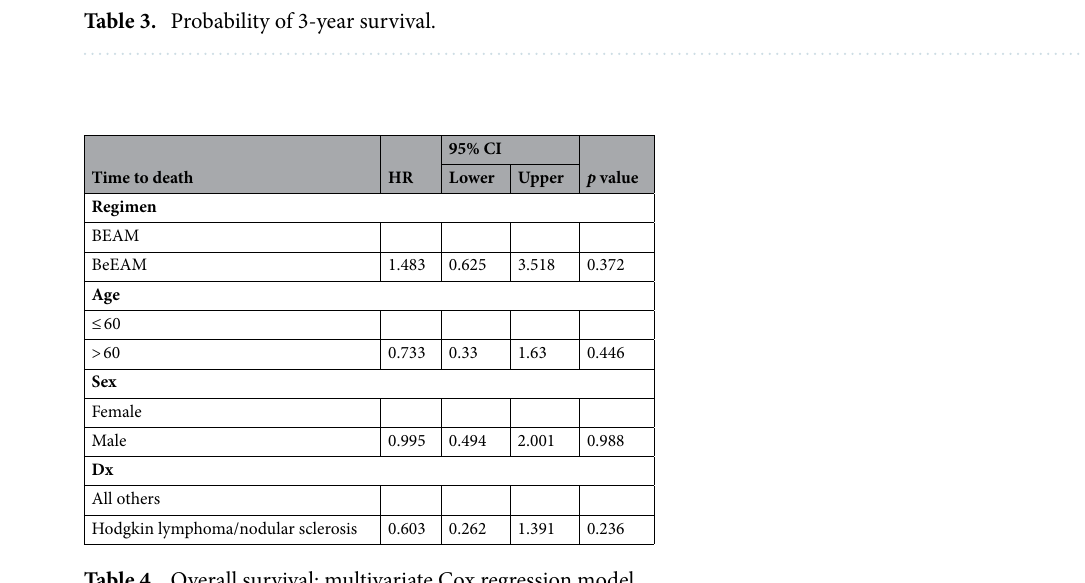
Table 4. Overall survival: multivariate Cox regression